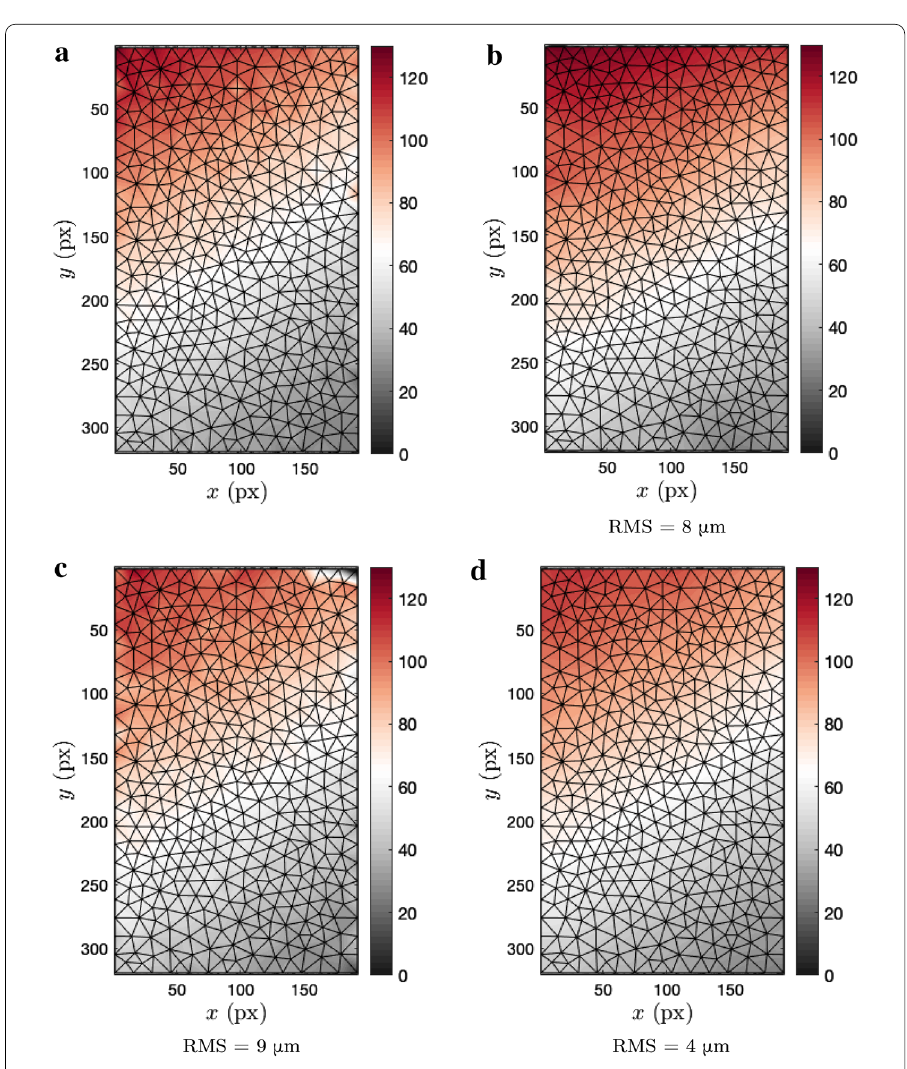
Fig. 7 Displacement fields (in µ m) along x at t = 85 µ s. a Reference solution, b instantaneous DIC, c spatiotemporal DIC, d dynamically regularized DIC ( (cid:8) D = 75 pixels). All analyses lead to very low RMS differences between measured displacement fields and the reference solution. The dynamically regularized solution lowers the RMS difference by a factor of 2 in comparison with the other two analyses